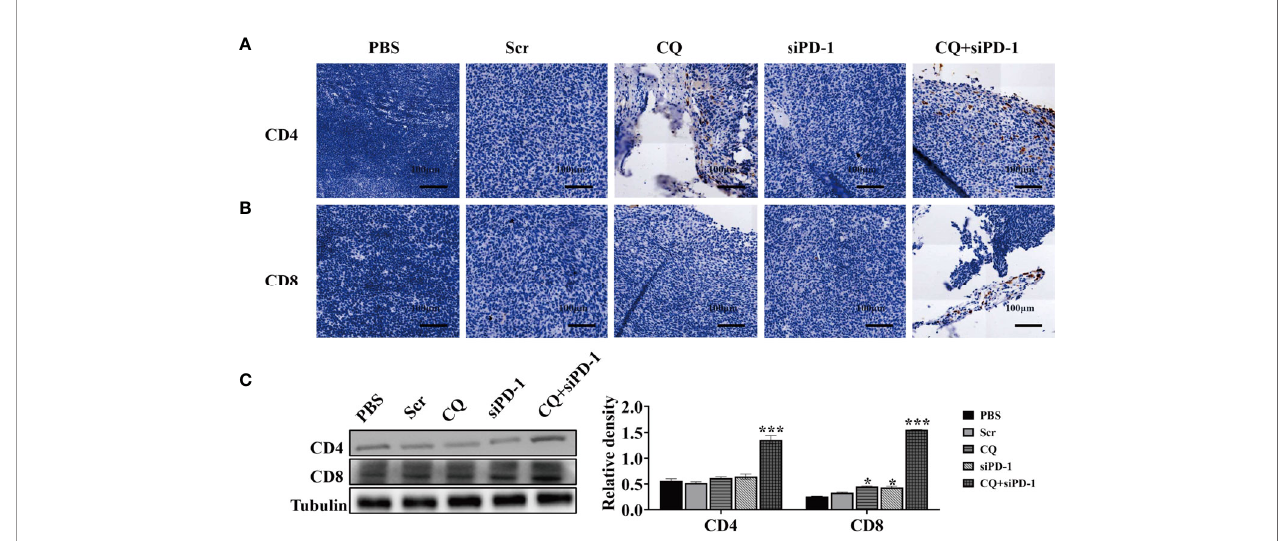
FIGURE 6 | Chloroquine combined with PD-1 siRNA can promote the in fi ltration of T cells into tumor tissues and inhibit the expression of PD-1. (A, B) IHC detects the expression of CD4 + and CD8 + in tumor tissues. (C) The protein levels of CD4 and CD8 in tumor tissue after the indicated treatments were evaluated by Western